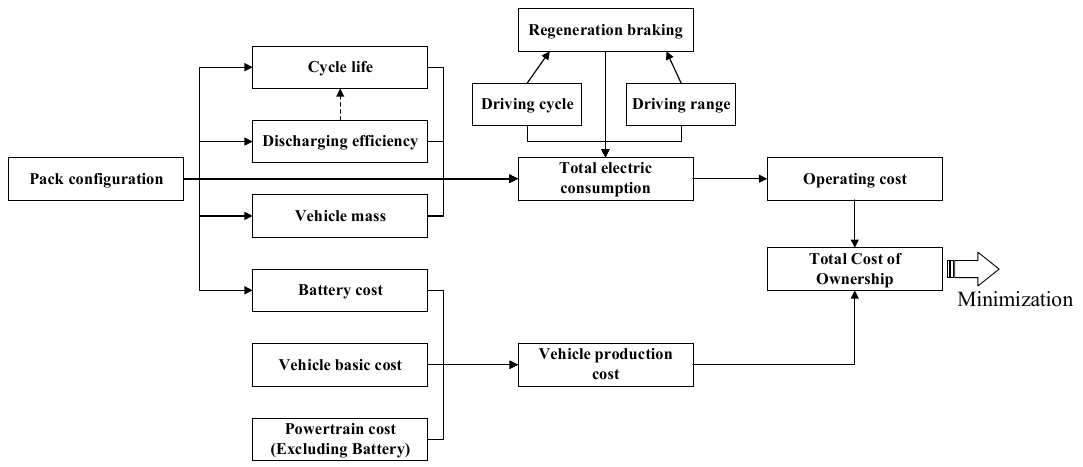
Figure 1. Structure of the battery combination optimization problem for BEVs.